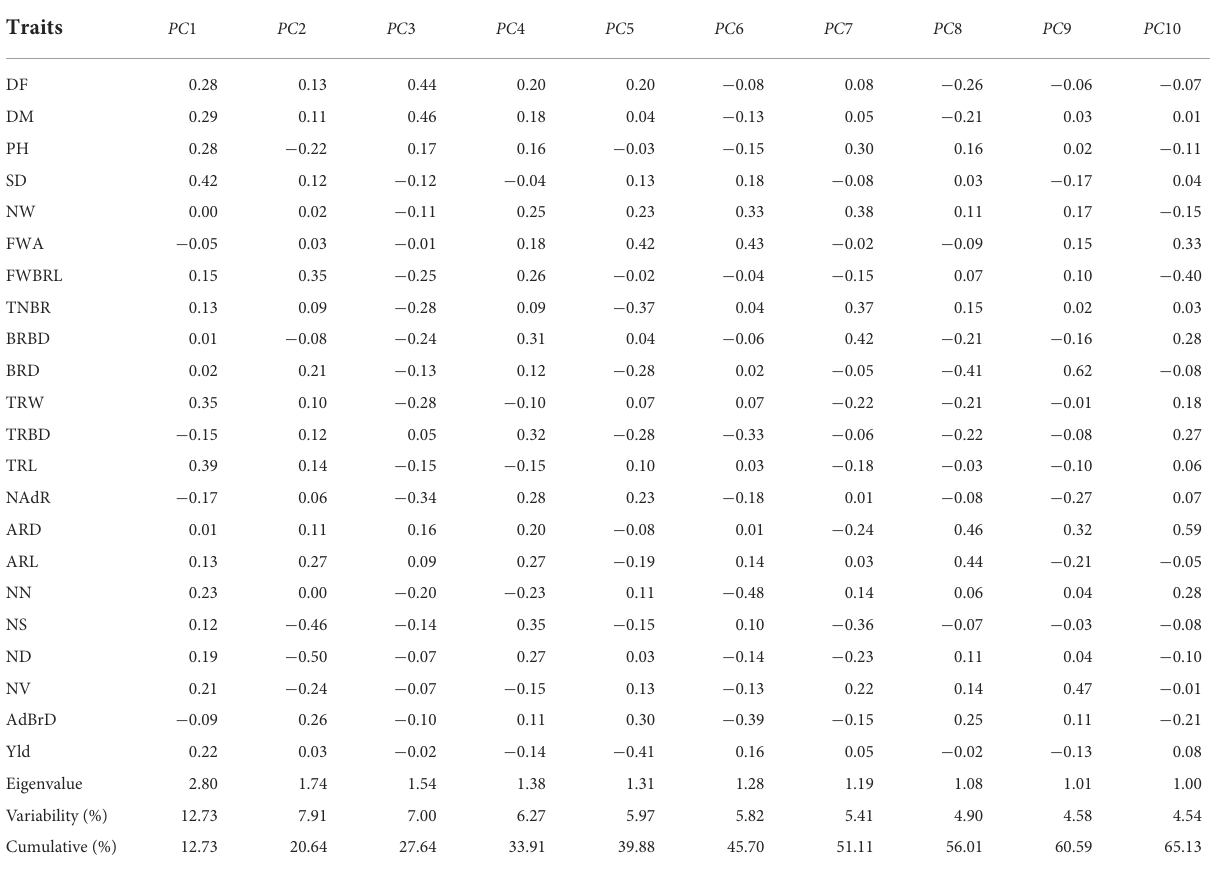
TABLE 4 Principal component analysis results for 324 cowpea